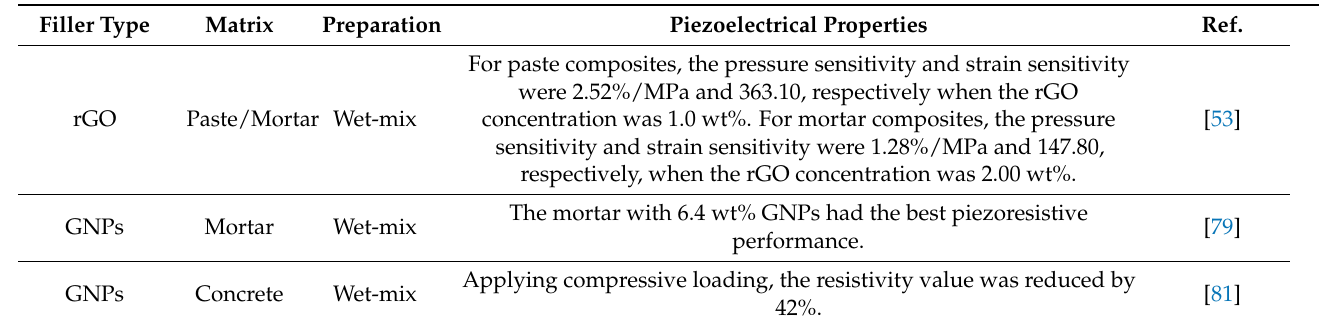
Table 4. Summary of studies on piezoelectrical properties of